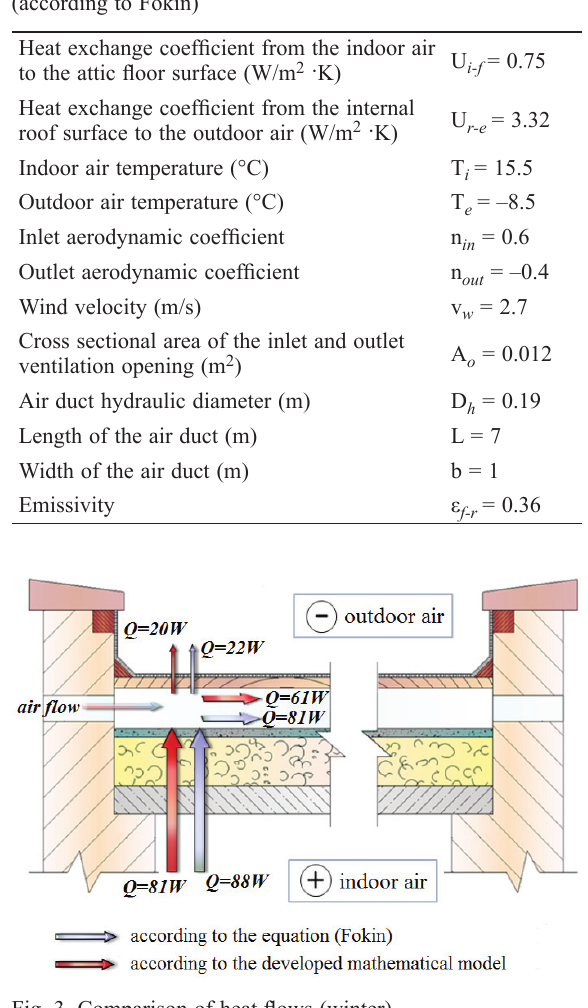
Fig. 3. Comparison of heat flows (winter)